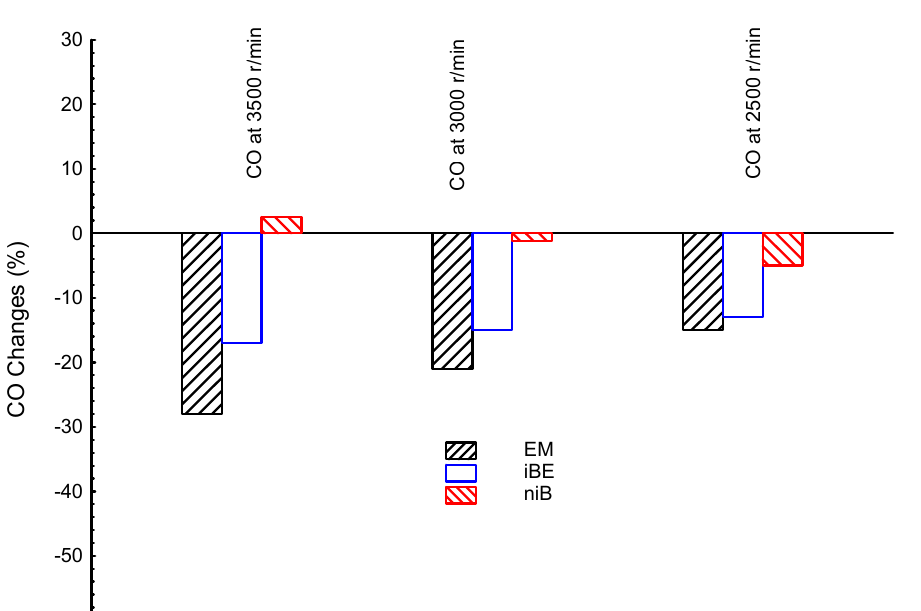
Figure 6. CO emissions at three different engine speeds (3500, 3000, and 2500 r/min) for ternary blended fuels of bio-ethanol–bio-methanol–gasoline (EM), iso-butanol–bio-ethanol–gasoline (iBE), and n-butanol–iso-butanol–gasoline (niB); gasoline is the reference line. The unburned hydrocarbons (UHC) are also investigated in the study. Figure 7 shows the UHC emissions at three different engine speeds (3500, 3000, and 2500 r/min) for ternary blended fuels of EM, iBE, and niB, as well as conventional gasoline as a reference line. It can be seen that the EM showed the lowest values at all speeds followed by iBE, and finally niB, similarly to the CO results. Additionally, all ternary blends presented lower UHC emissions than the G fuel.